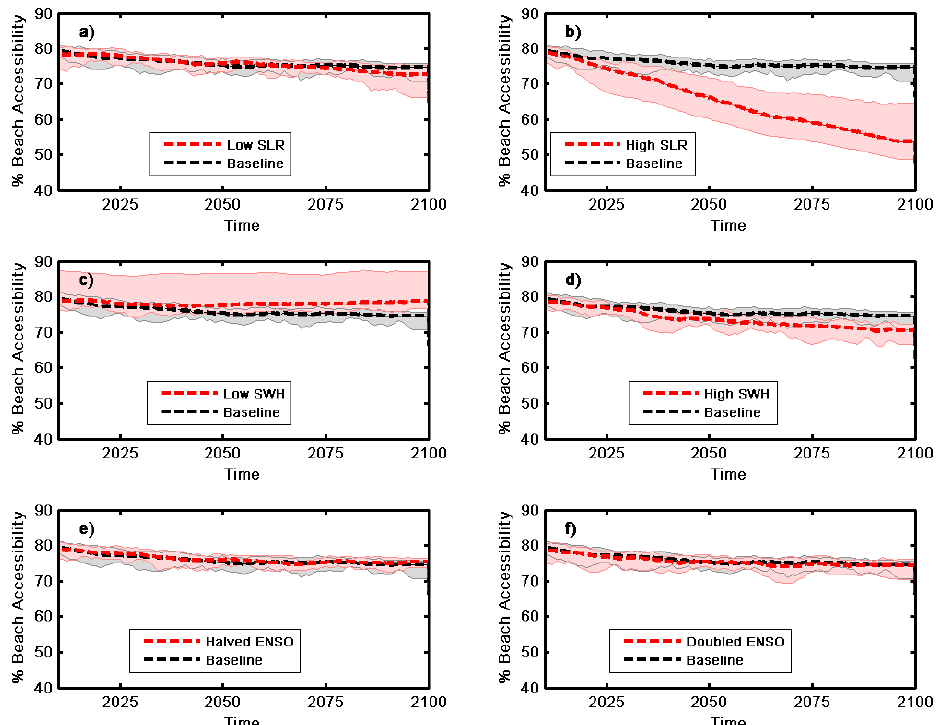
Figure 8. Beach accessibility through time under each of the climate drivers (panels a – f ). Dashed lines indicate the decadal mean of all simulations. Bounds represent the minimum and maximum decadal means.